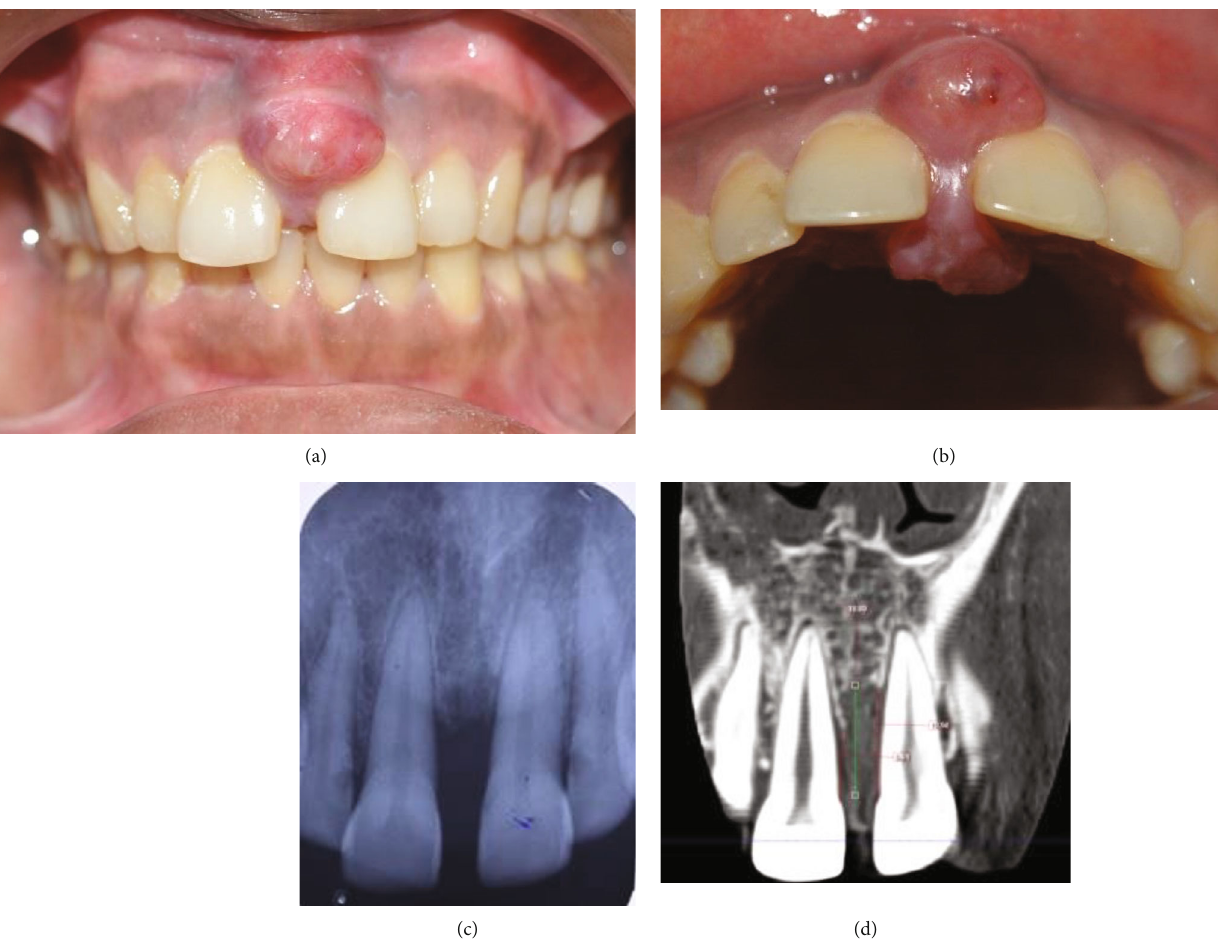
Figure 1: (a) and (b) Dumbbell-shaped swelling involving the buccal and palatal aspect. (c) Intra-oral peri-apical radiograph showing interdental bone loss between maxillary central incisors; (d) CBCT showing bone loss in the mid-alveolus